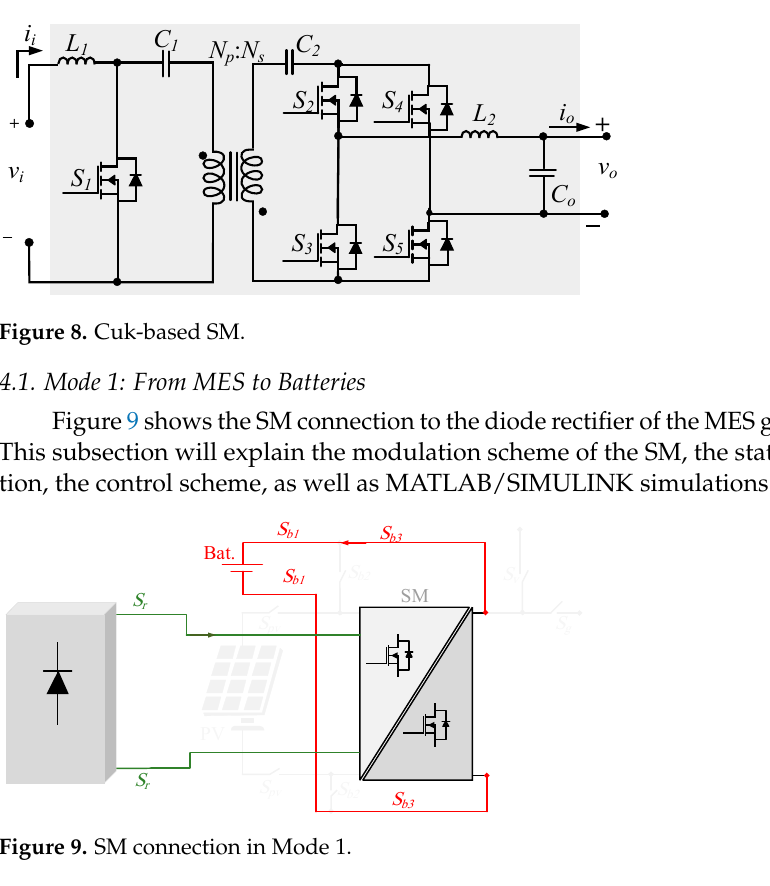
( c ) Figure 10. Cuk SM currents during Mode 1: ( a ) St dc1 , ( b ) St dc2, and ( c ) modulation scheme. 4.1.2. Control System The state vector of the SM in this case can be assumed as x ( t ) = [ i i ( t ) v C t ( t ) i L2 ( t ) v o ( t ) i o ( t )] and the output y dc ( t ) = i o ( t ) is the battery current. v b is the battery voltage, L b is its equiv- alent inductance, and r b is its internal resistance. The large-signal average model is de- duced in (4).